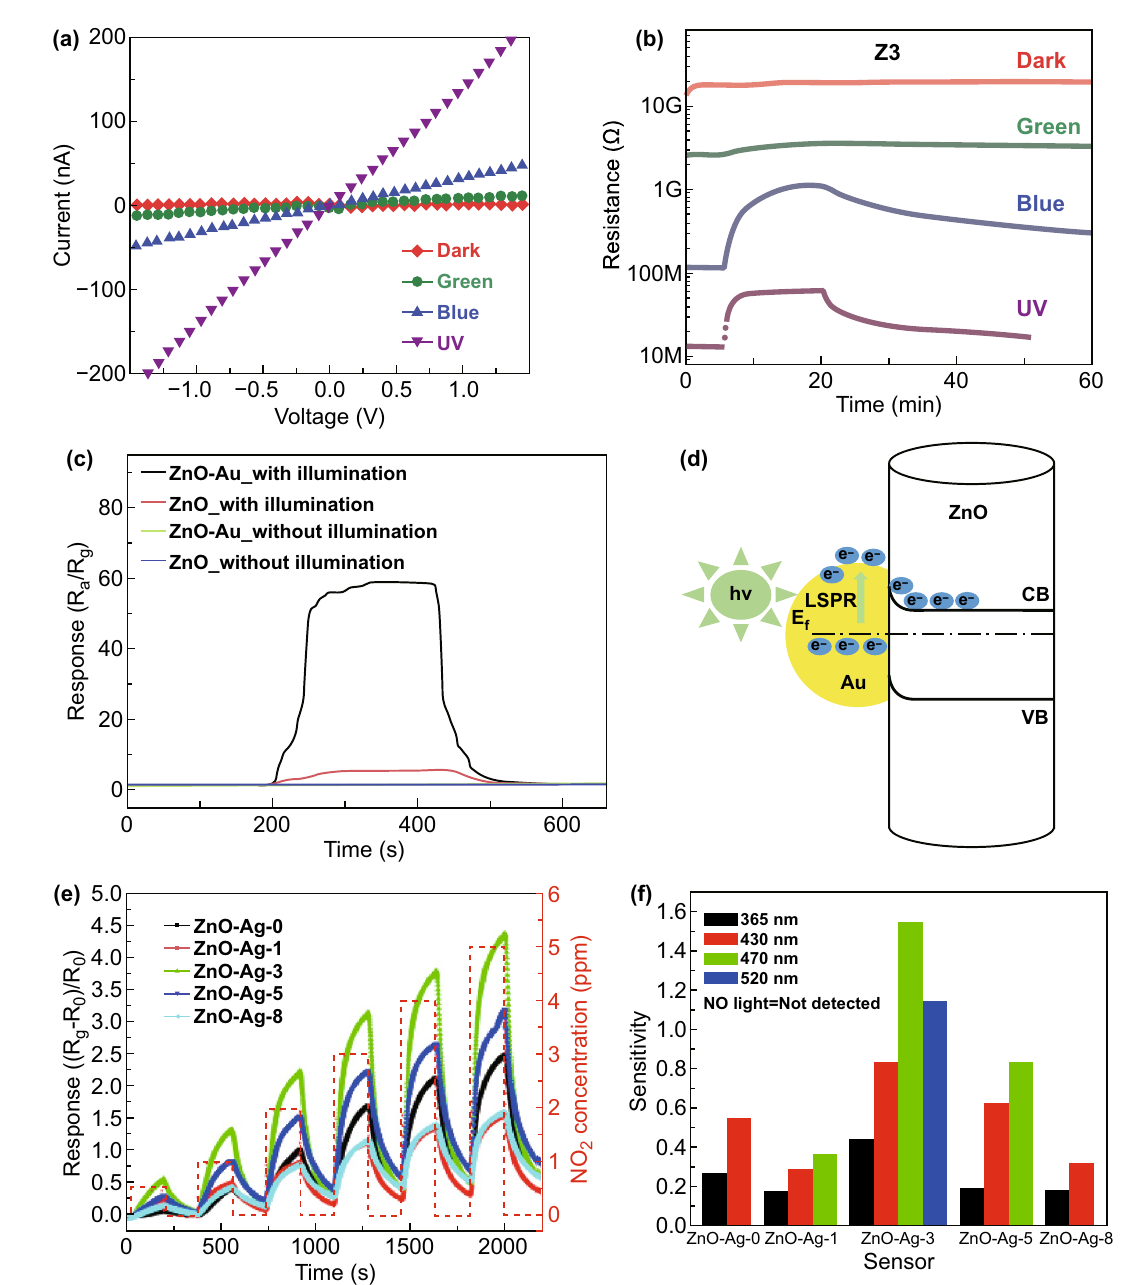
Fig. 2 a Current–voltage ( I – V ) characteristics of ZnO film (8 nm) measured in dark and various wavelength light irradiation. b Resistance change of ZnO film (37 nm) to 10 ppm NO under the light of different wavelengths. Reproduced with permission [36]. Copyright 2018, Elsevier. c Real-time sensing response curves to 500 ppm ethanol of sensors made of ZnO and Au-decorated ZnO at RT with or without white illumina- tion. d Electron transfers from Au to ZnO due to the LSPR excitations in Au. Reproduced with permission [54]. Copyright 2017, Elsevier. e Dynamic response curves of sensors based on pure ZnO and Ag/ZnO to 0.5–500 ppm NO 2 under 430 nm light illumination at RT. f Sensitivities of sensors based on pure ZnO and ZnO-Ag heterostructure nanoparticles to 0.5–500 ppm NO 2 illuminated at various light wavelengths at RT. Reproduced with permission [55]. Copyright 2017,